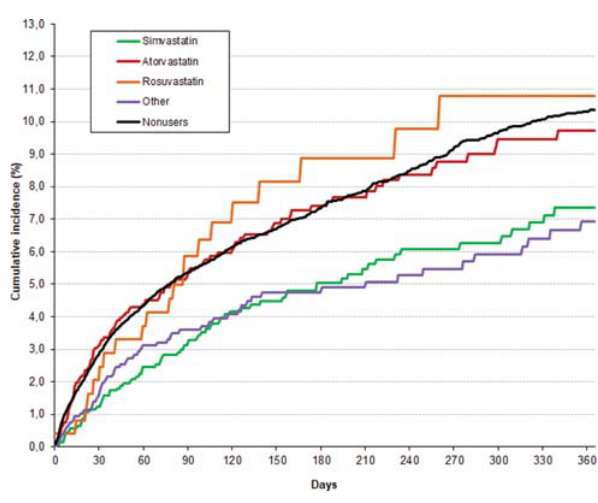
Fig. 2 Cumulative mortality rates according to type of statin